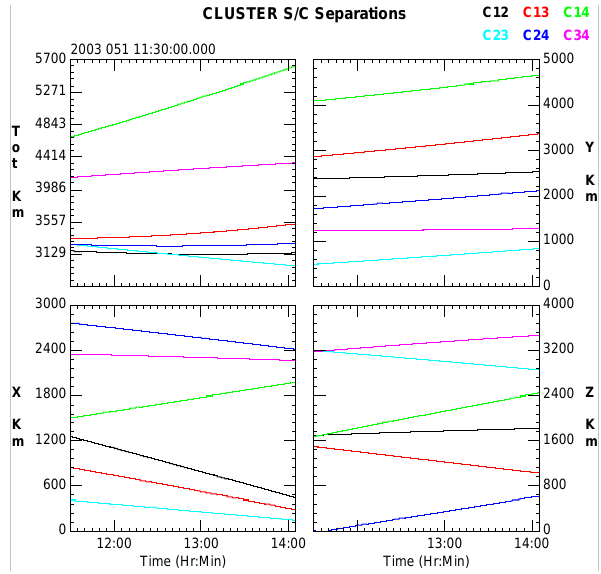
Fig. 6. Total and GSE component spacecraft separations over the time interval being analyzed.